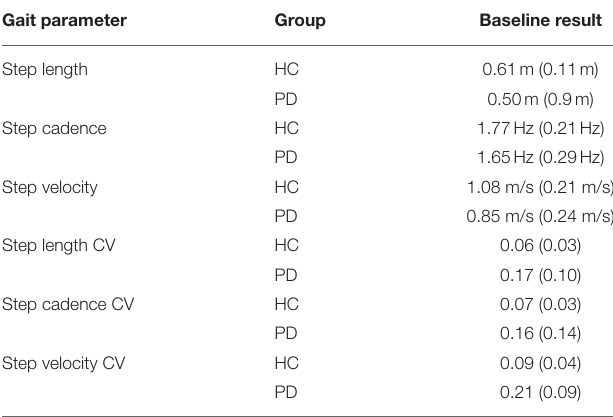
TABLE 2 | Table containing the results for the six different gait parameters in the baseline